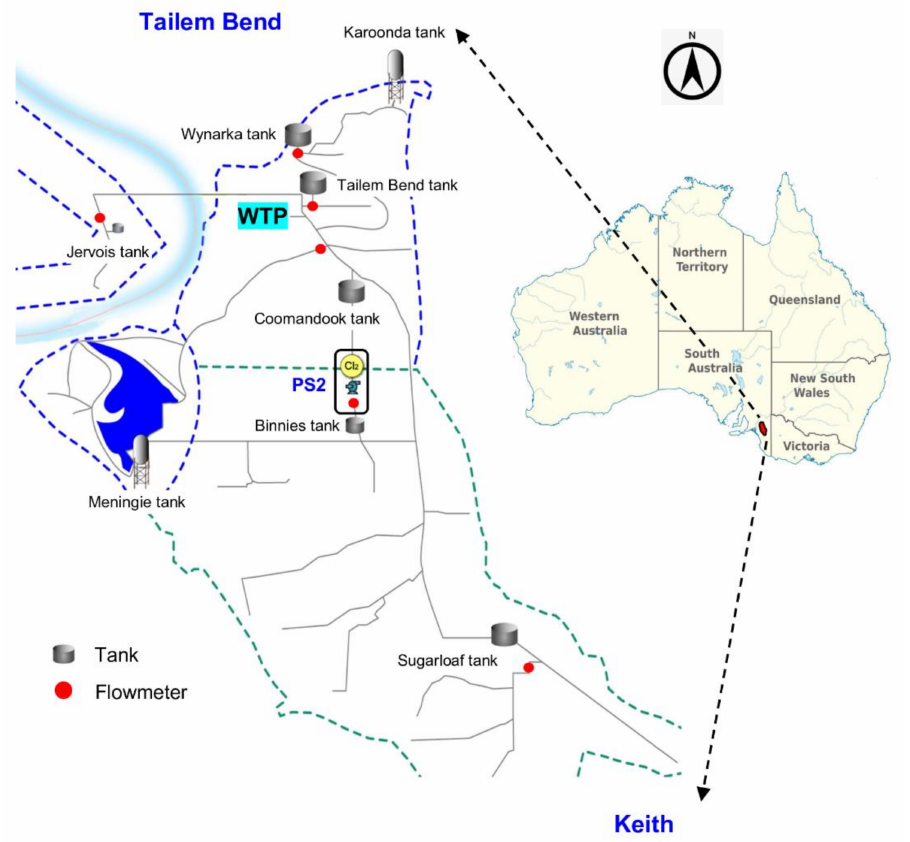
Figure 1. Layout of the Tailem Bend–Keith (TBK) drinking water distribution